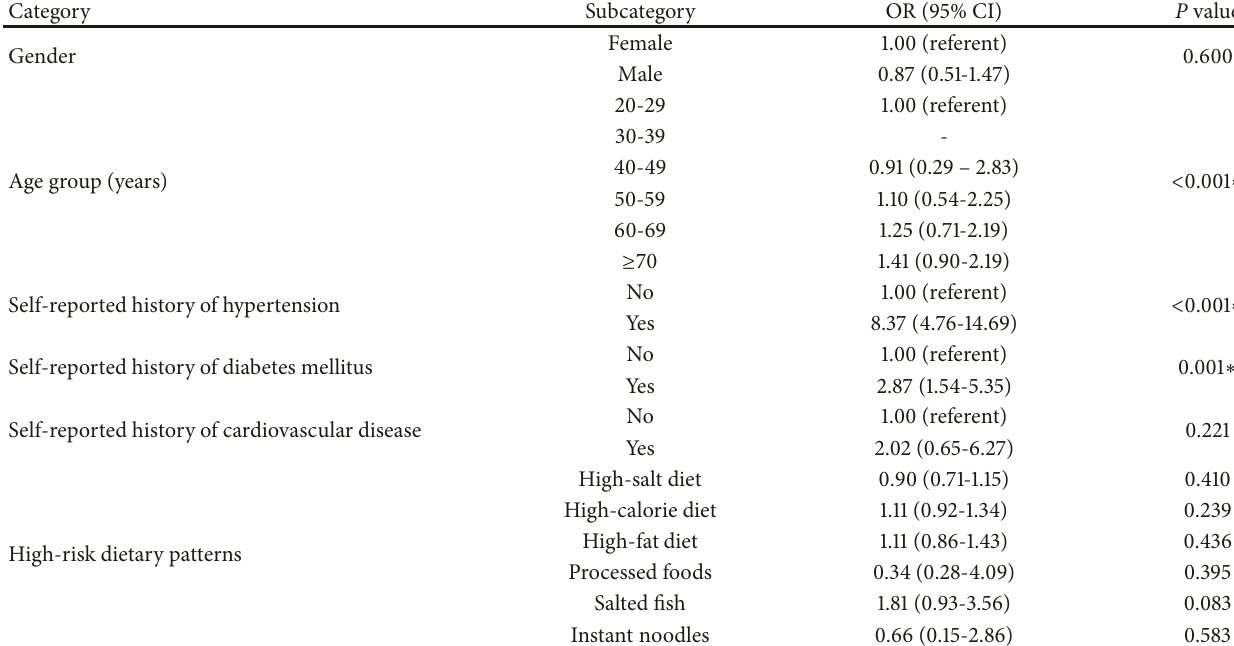
Table 4: Multivariable logistic analysis of stroke risk factors among study